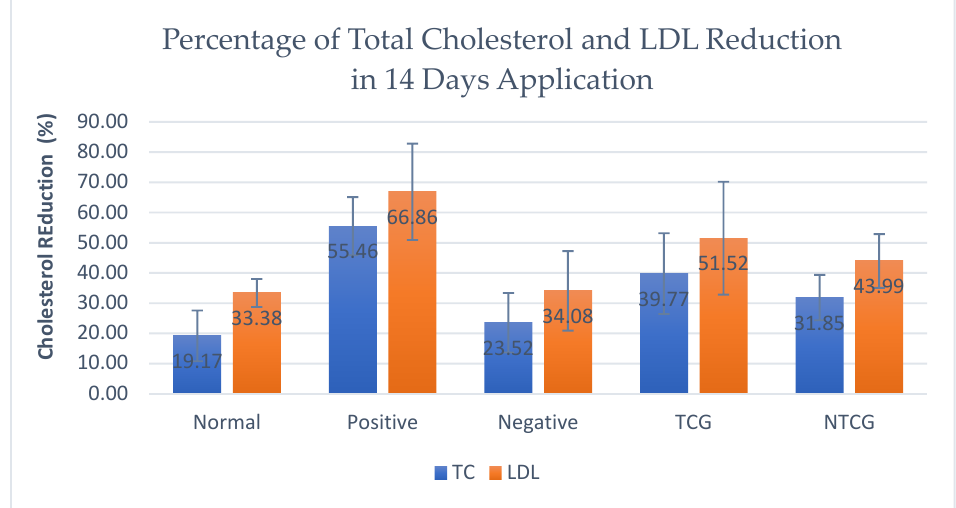
Figure 12. Graph of cholesterol reduction percentage in 14 days application of Total Cholesterol and LD. Table 7. The results of statistical significance calculations between test groups.